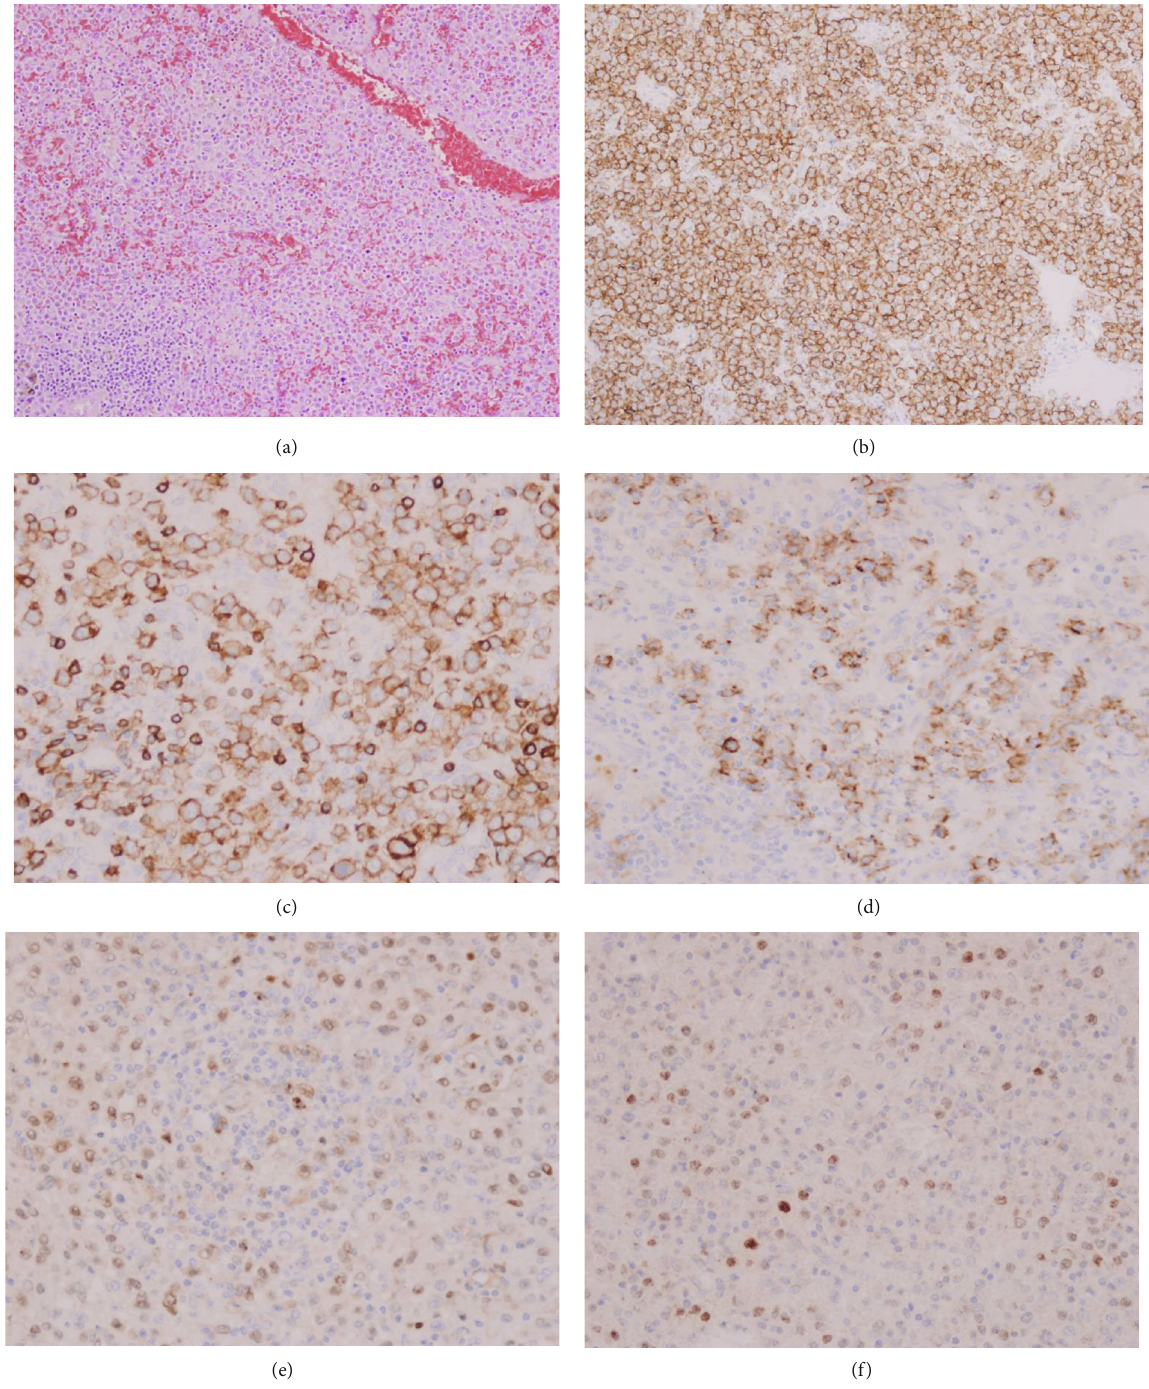
Figure 1: Pleomorphic mantle cell lymphoma involves the spleen. (a) Di ff use in fi ltration of the splenic red pulp by large-sized tumor cells with clumped chromatin and conspicuous nucleolus (100x). (b) Immunostain for CD20 demonstrates membranous pattern positivity (200x). (c) Immunostain for CD5 reveals membranous pattern positivity (400x). (d) Immunostain for CD23 exhibits partial membranous pattern positivity (400x). (e) Immunostain for cyclin D1 demonstrates partial nuclear positivity (400x). (f) Immunostain for SOX11 presents with partial nuclear pattern positivity